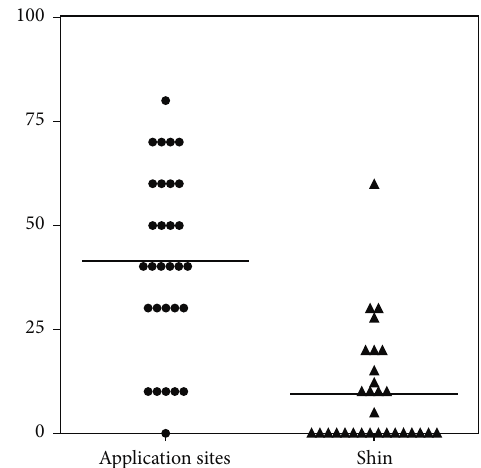
Figure 1: The VAS scale was significantly lower in the post-RTP group than in the pre-RTP group ( p < 0 . 01).